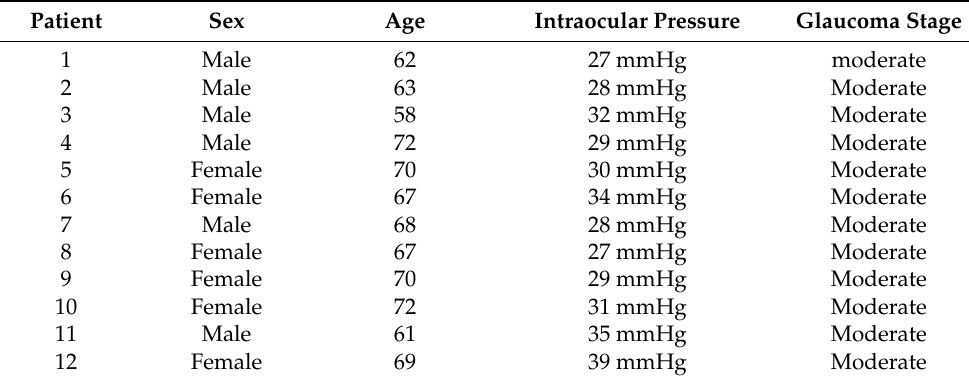
Table 1. Intraocular pressure (IOP) before